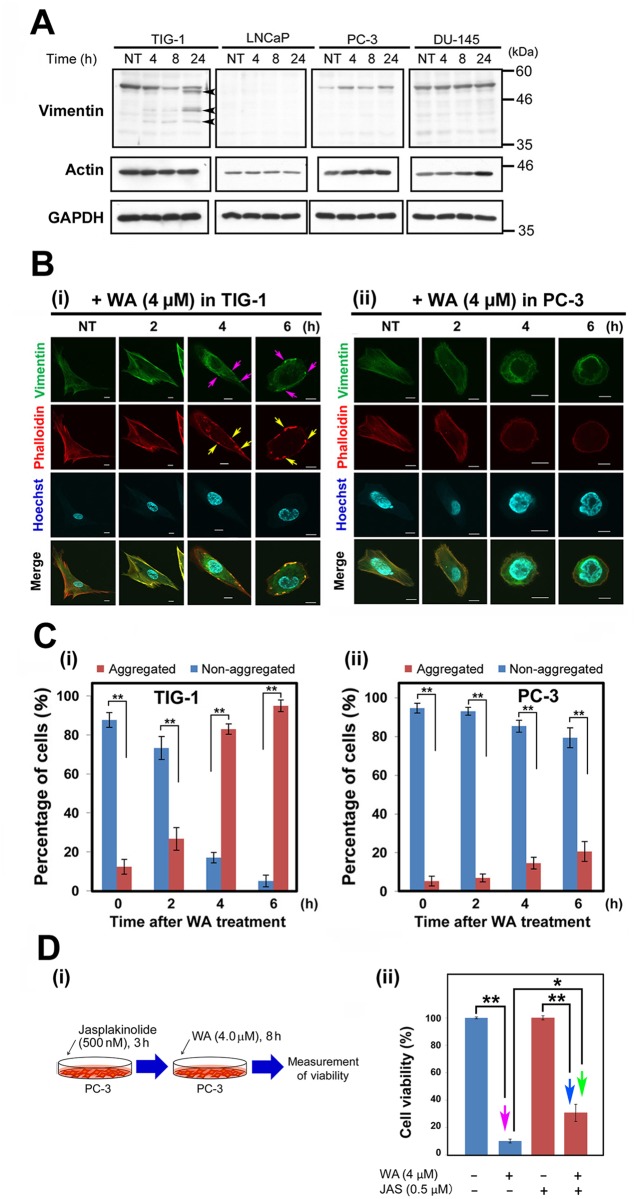
Protein levels and localizations of vimentin and F-actin following WA treatment.(A) Western blot analysis to detect vimentin and actin in TIG-1, LNCaP, PC-3, and DU-145 at 4, 8, and 24 h after treatment with 2 μM or 4 μM WA. NT: non-treated. (B) Typical images of TIG-1 (i) and PC-3 (ii) stained with anti-vimentin antibody, phalloidin (for F-actin), and Hoechst 33342 (for DNA) at 2, 4, and 6 (h) after WA treatment. NT: non-treated. Pink and yellow arrows indicated colocalized vimentin and F-actin aggregates. Merged images are shown in the bottom row. Bar, 10 μm. (C) Percentage of all observed cells containing dots of aggregated or non-aggregated vimentin are shown for TIG-1 (i) and PC-3 (ii). Cells harboring over 10 vimentin aggregates were scored as “aggregated”, whereas cells with non-aggregated vimentin were scored as “non-aggregated”. Data are represented as means ± SEM of three independent experiments; asterisks indicate statistically significant changes in cell viability (**, P < 0.01; ***, P < 0.001). (D) Jasplakinoloide (Jsp) did not influence PC-3 cell viability. (i) Schematic of the experimental design. (ii) Bar graphs showing cell viability (%) in the presence (+) or absence (-) of 4 μM WA or Jasp 8 h after the addition of WA. NT: non-treated. Bar graphs represent means ± SEM for three independent experiments. Pink, blue, and green arrows indicate statistically significant reductions in cell viability (*, P < 0.05; **, P < 0.01).